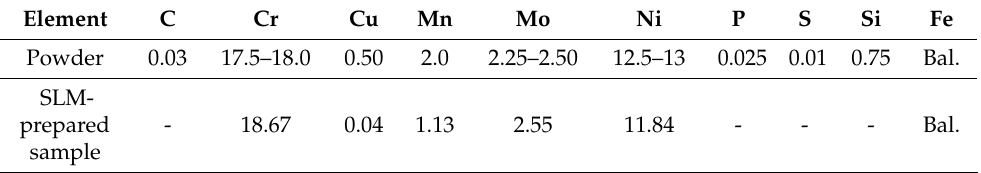
Table 1. Chemical composition (in wt.%) of the 316L SS powder and the SLM-prepared sample.